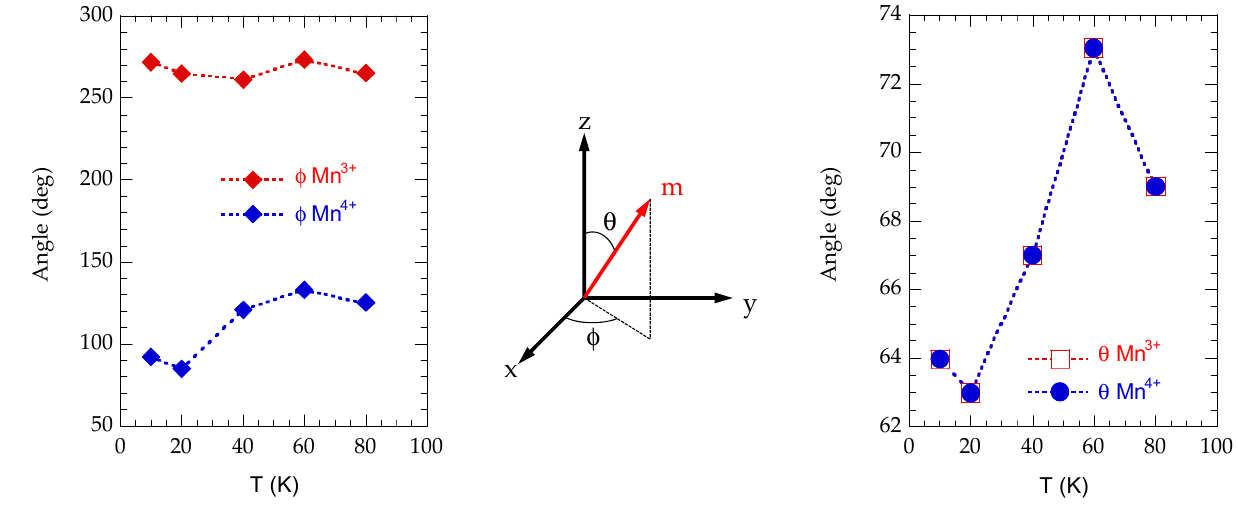
Figure 10. Spherical coordinates representation of the magnetic moment m of formally Mn 3+ and Mn 4+ ions, relative to the x-y-z axes of the Pbnm cell, as obtained by the neutron diffraction patterns of the nanoparticles refined with a single nuclear Pbnm phase and a single 2a × 2b × c magnetic supercell.